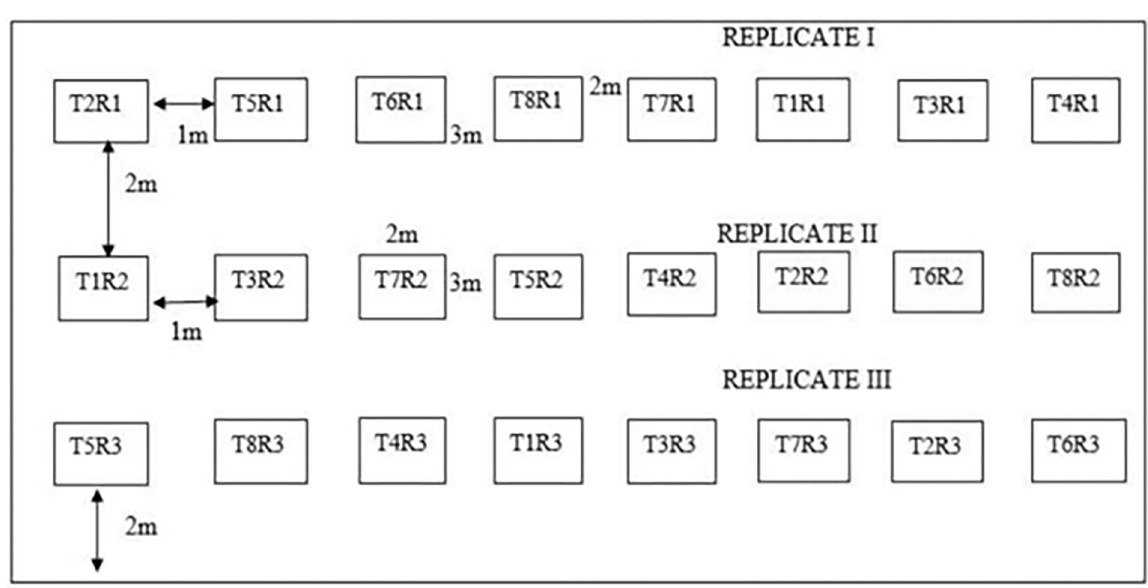
Fig 1. Field layout of the experiment.